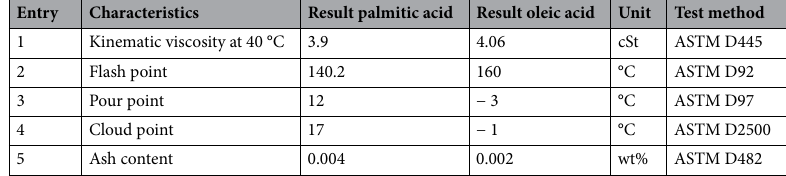
Table 3. Fuel properties of biodiesel.